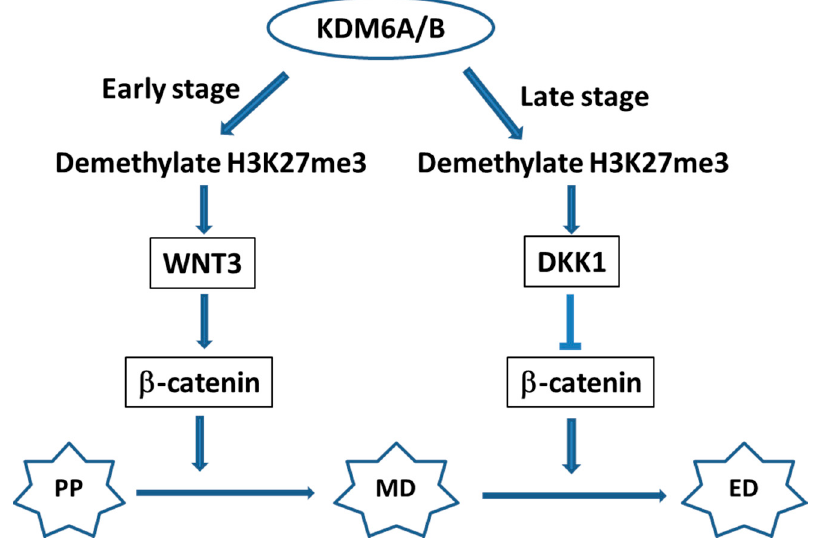
Figure 1. Proposed model of the role of KDM6A/B in definitive endoderm differentiation. At early stage of definitive endoderm differentiation from human embryonic stem cells, KDM6A/B demethylate H3K27me3 which leads to upregulation of WNT3 expression and activation of WNT signaling pathway, which further promotes mesendoderm differentiation. At late stage, KDM6A/B activates DKK1, a WNT antagonist, to suppress WNT signaling pathway and promote mesendoderm to endoderm differentiation. Arrow indicates activation and T-bar indicates inhibition. PP: pluripotent; MD: mesendoderm; ED: endoderm.